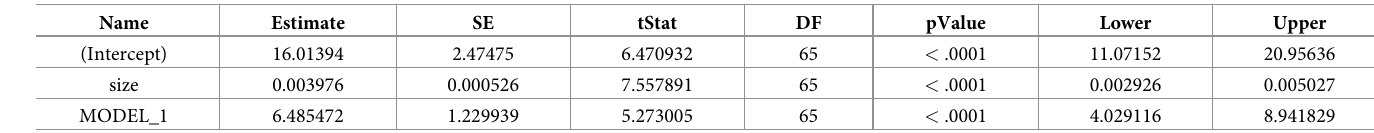
Table 4. The fixed effects coefficients of the model explaining the tour cost in terms of the HPN/GPN and the problem size.